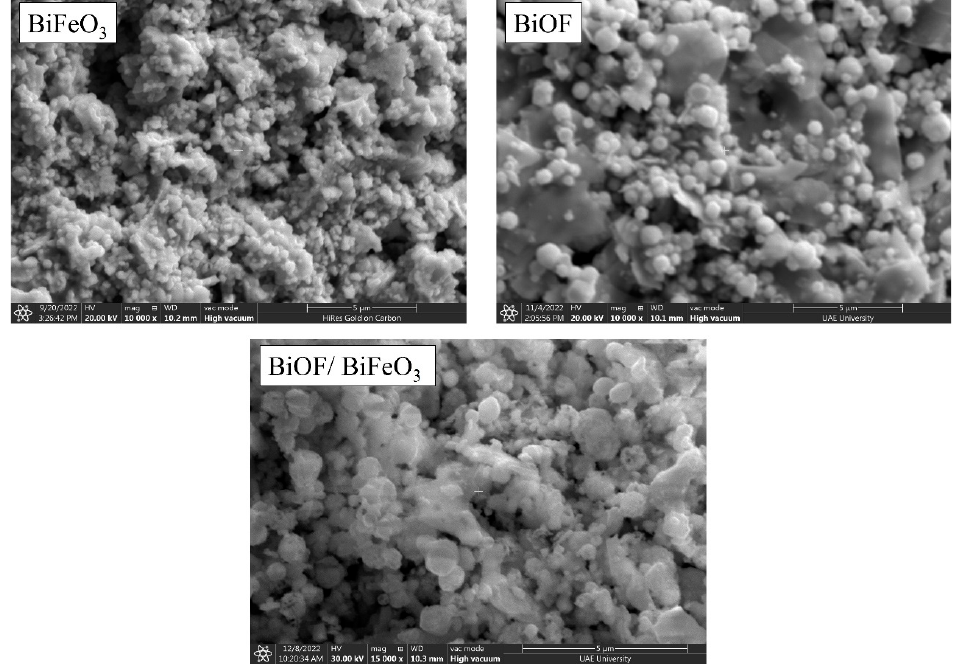
Figure 3. SEM images of the photocatalysts material at 5 µm scale bar.